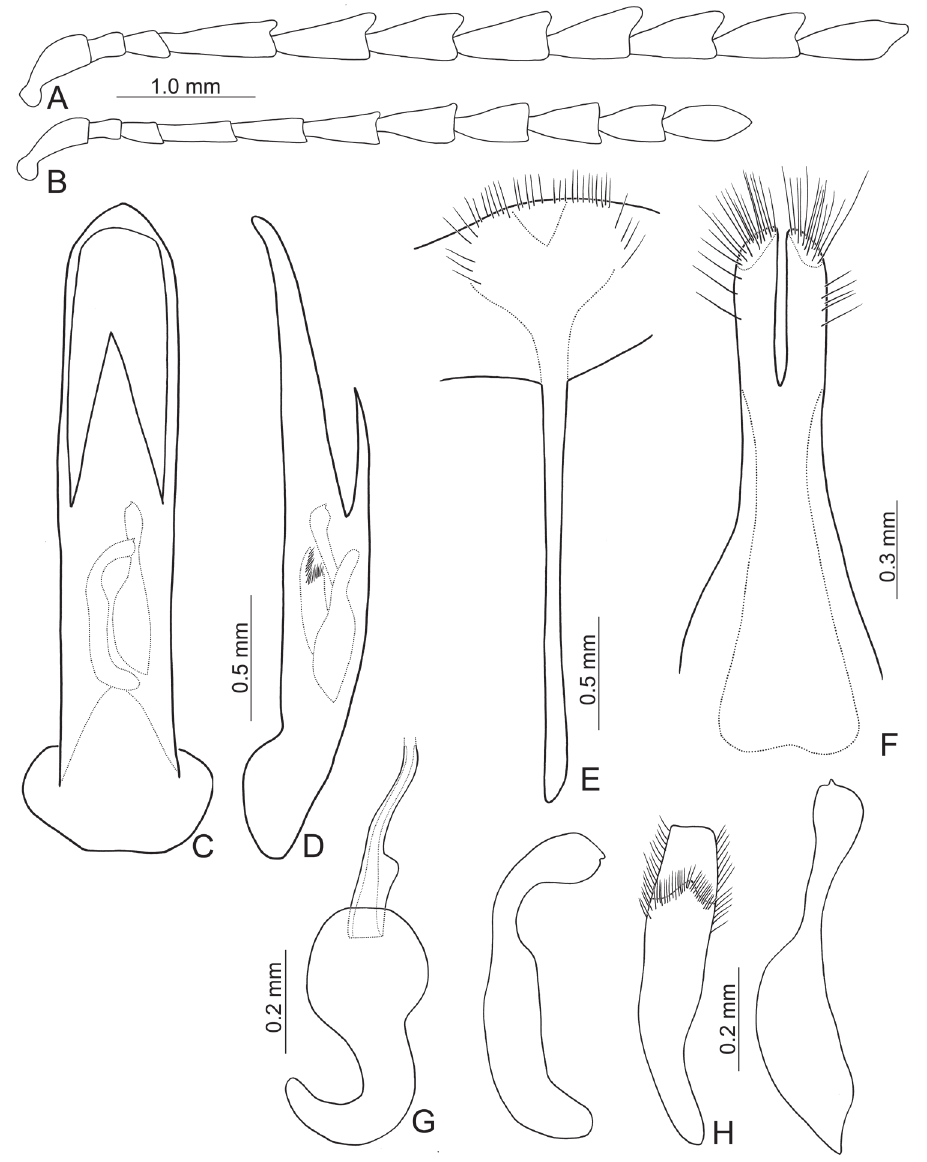
Figures 2. Diagnostic characters of Gallerucida bifasciata Motschulsky. A Antenna, male B Antenna, female C Penis, dorsal view D Penis, lateral view E Abdominal ventrite VIII F Gonocoxae G Spermatheca H Endophallic